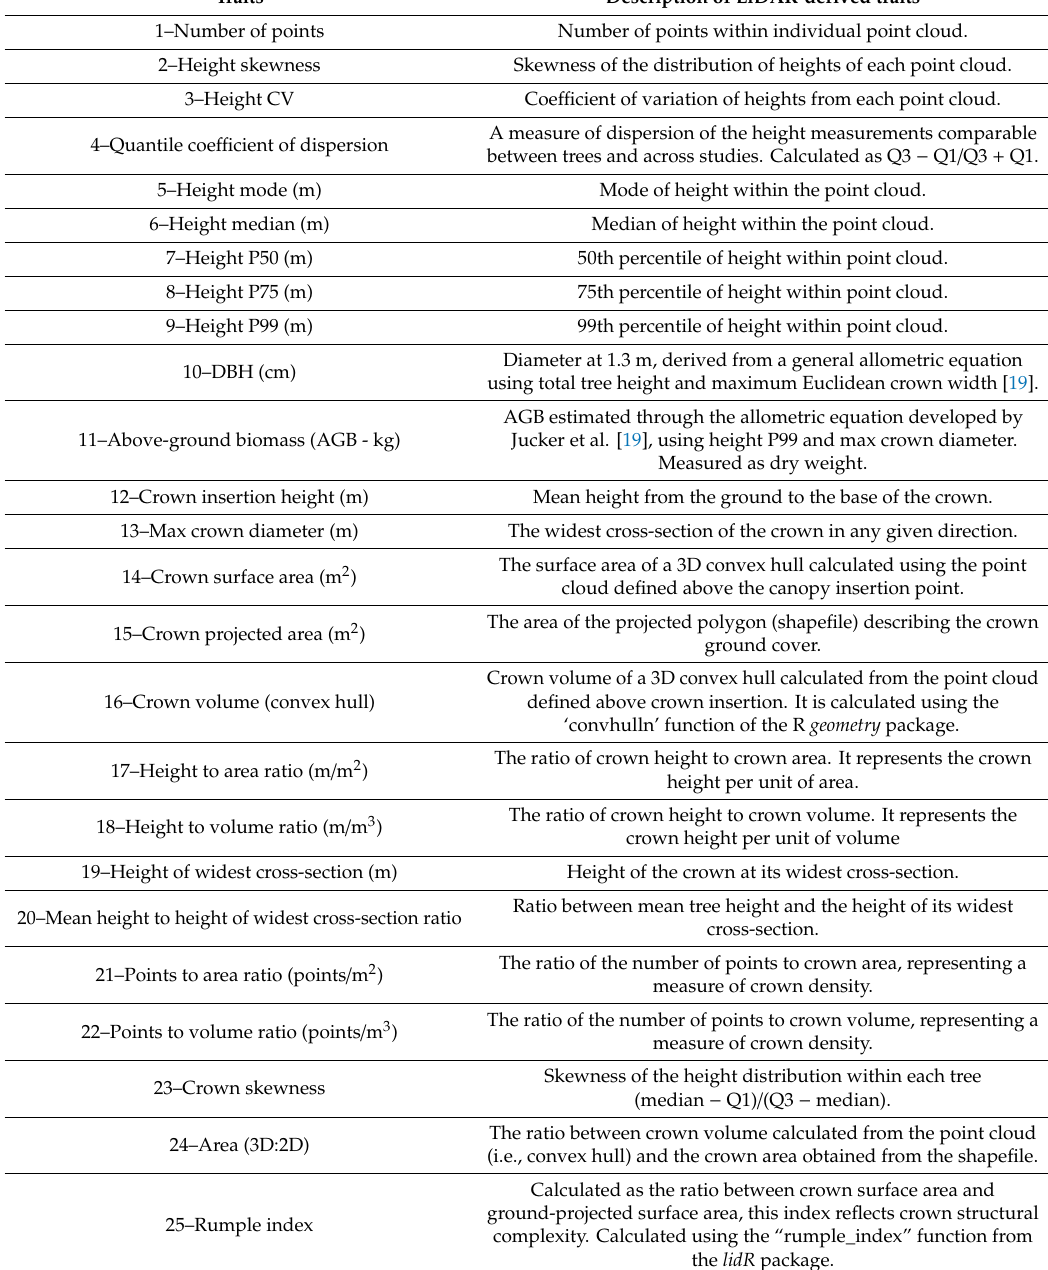
Table 1. Description of the 25 derived traits from the individual tree-level LiDAR point clouds. The unit of measurement for eachderived trait is shown after the trait